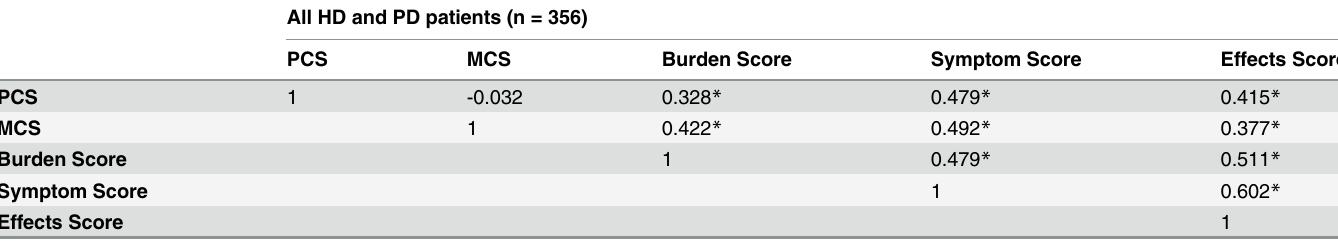
Table 5. Pearson's correlations of generic and disease specific domains of KDQOL-36.